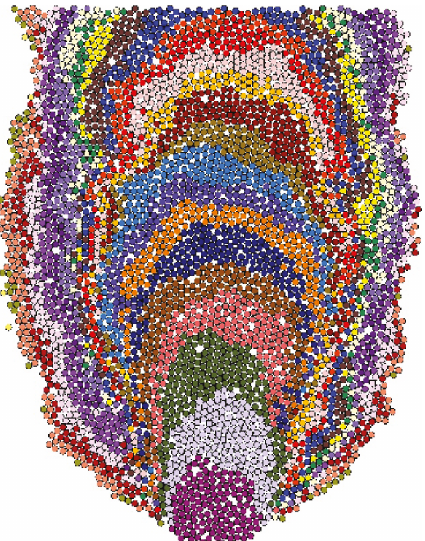
Figure 5: Morphology evolution process of the draw column in the